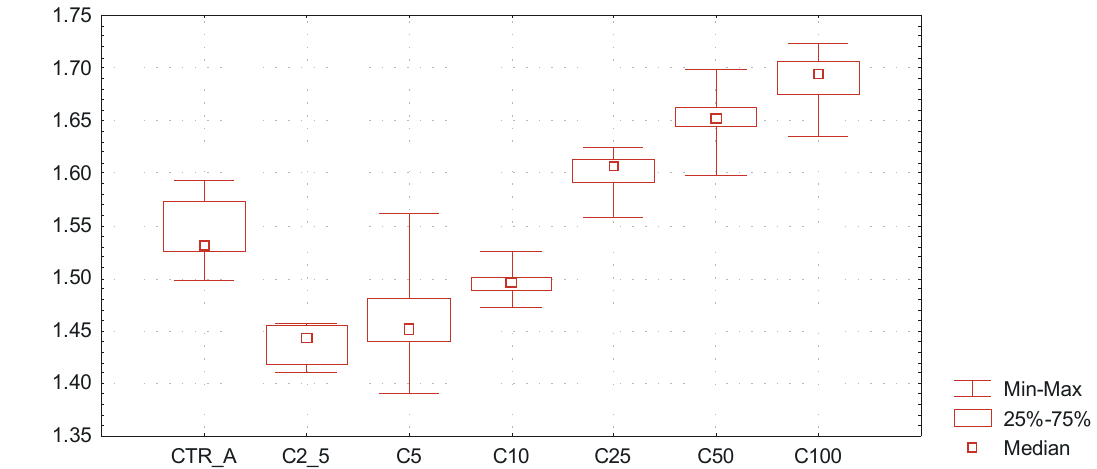
Figure 3. Dose-dependent effect of EtOH alone and combination of EtOH with caffeic acid (CFA) on SCC-25 cells proliferation assessed by MTT absorbance measurement. Higher cytotoxicity of combination of EtOH and CFA (50 μ mol/L) compared to the separate action of ethanol alone, accompanied by decreased viability of SCC-25 cells. Statistically significant differences considering the mean absorbance values between group A and group B, comparing the same EtOH concentrations (for the EtOH concentrations above 2.5 mmol/L). A significant variation of MTT absorbance values compared to ethanol alone. X axis—EtOH concentrations [C]; CTR_B—control sample B; Y axis—absorbance